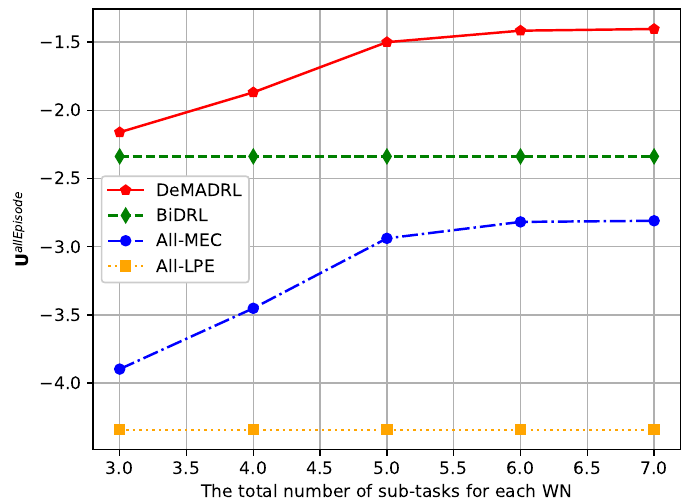
Figure 6. Comparison on four algorithms with different probability of arrival tasks.